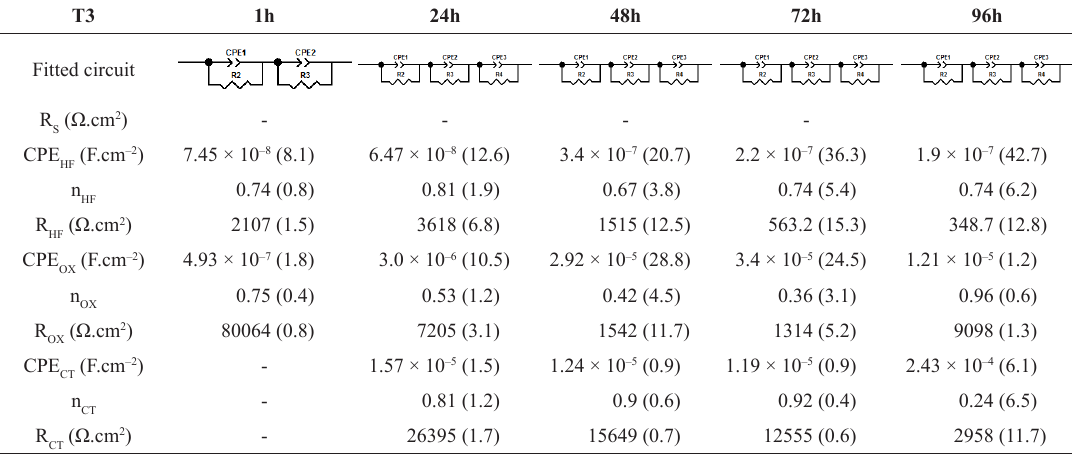
Table 8. Electrical elements fitted values for the T3 sample up to 96 hours of immersion in a 0.05 mol.L –1 NaCl solution. The error percentage associated with each parameter value is given in